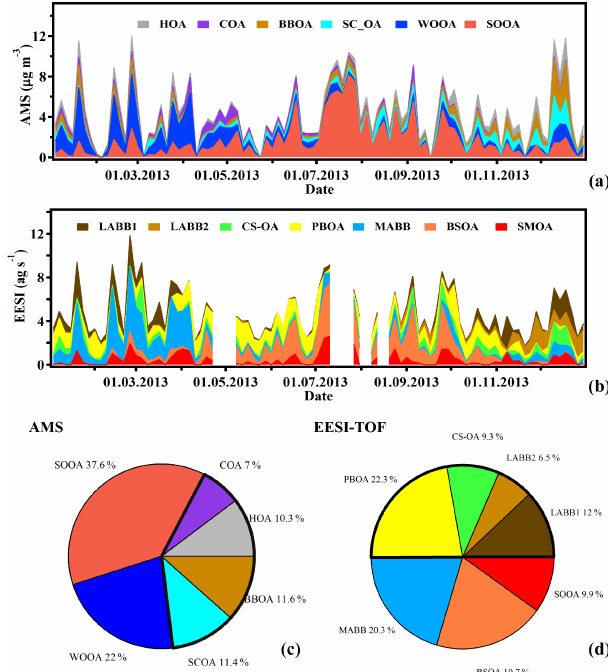
Figure 10. Comparison between AMS factors and EESI factors: time series of the concentrations of the AMS PMF factor (a) and mass flux of EESI PMF factor (b) . Pie charts of source apportion- ment results from the EESI (c) and AMS (d)